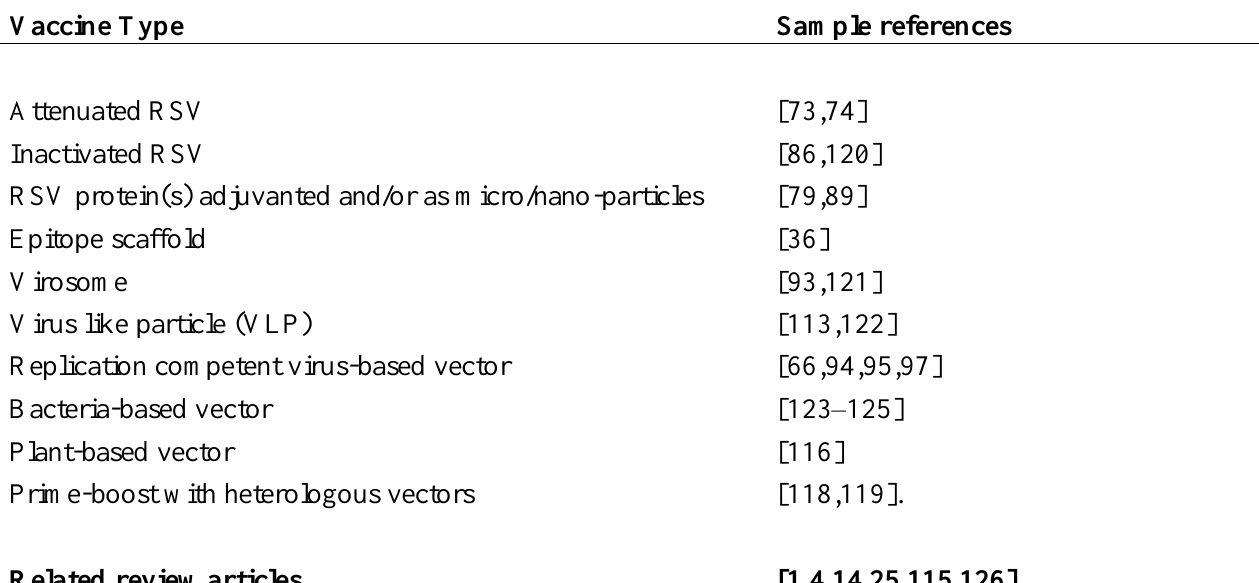
Table 1. Sample respiratory syncytial virus (RSV) vaccine references and review